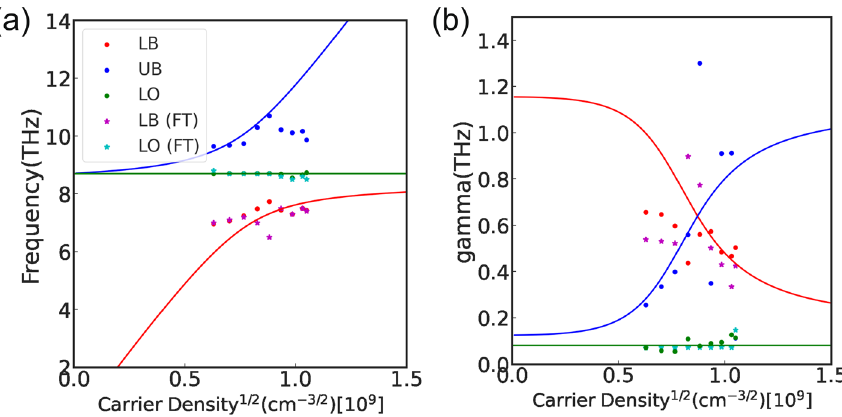
Figure 4. Carrier density dependence of the frequencies and damping rates. The measurement data is one point √ n for each carrier density. For both ( a ) and ( b ), the horizontal axis is pl . ( a ) Carrier density dependence of the peak frequencies extracted by DMD and Fourier spectrum (FT). The horizontal axis shows the square root of the carrier density, and the vertical axis shows the frequencies of each mode. Green, blue, and red plots show the LO, UB and LB, respectively. The solid line corresponding to each color shows the carrier density dependence of the real part of the complex energy eigenvalues obtained from Eq. (23). Note that the UB of Fourier spectrum is not shown because it was difficult to detect the peak of UB mode from the Fourier spectrum. ( b ) Dependence of the damping rate ˜ γ . The Fourier spectrum’s damping rate was estimated from the FWHM of the spectral peaks using the half-power method. The horizontal axis shows the square root of the carrier density, and the vertical axis shows the damping rate ˜ γ of each mode. The plot is color-coded in the same way as ( a ). The solid line shows the carrier density dependence of the imaginary part of Eq.